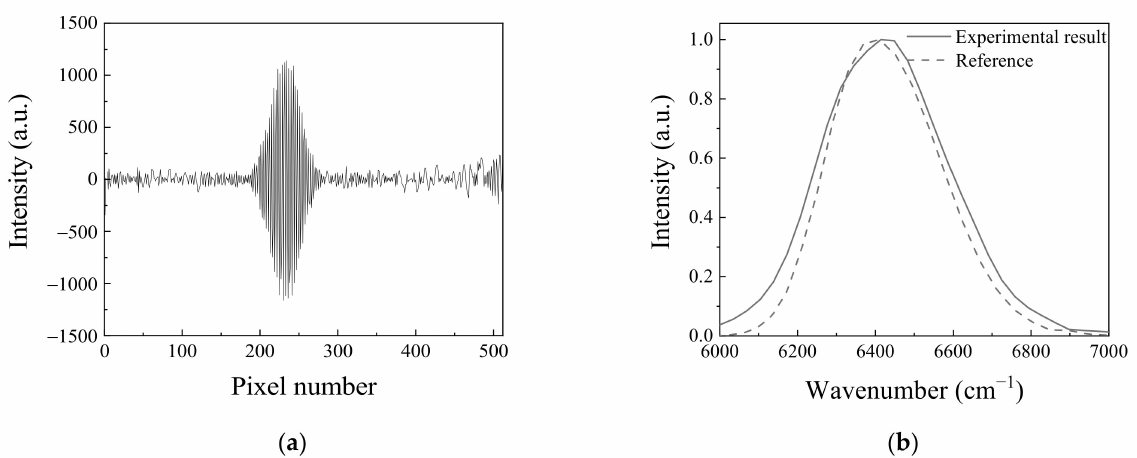
Figure 3. ( a ) The interferogram measured in the static modulated spectrometer with the modified Sagnac interferometer: ( b ) Spectrum comparison. Experimental result shows the spectrum that interferogram in Figure 3a is Fourier transformed and reference shows the spectrum measured using the monochromator. The applied current and temperature to the light emitting diode were 0.55 A and 25 ◦ C, respectively.